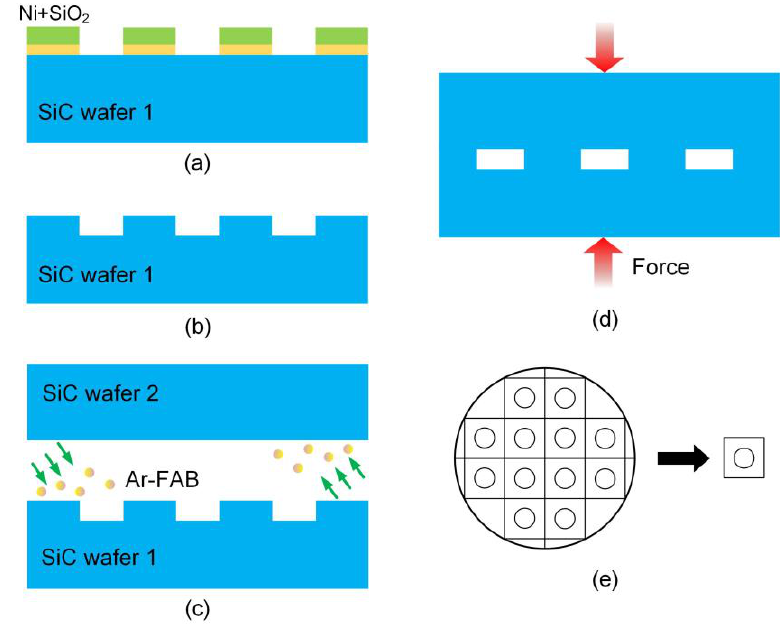
Figure 3. Fabrication process schematic of the SiC cavity structure: ( a ) etching of Ni and SiO 2 ; ( b ) cavity etched by ICP; ( c ) Ar-FAB bombardment;( d ) wafers contact each other under ~20MPa;( e ) bonded wafers cut into pieces.